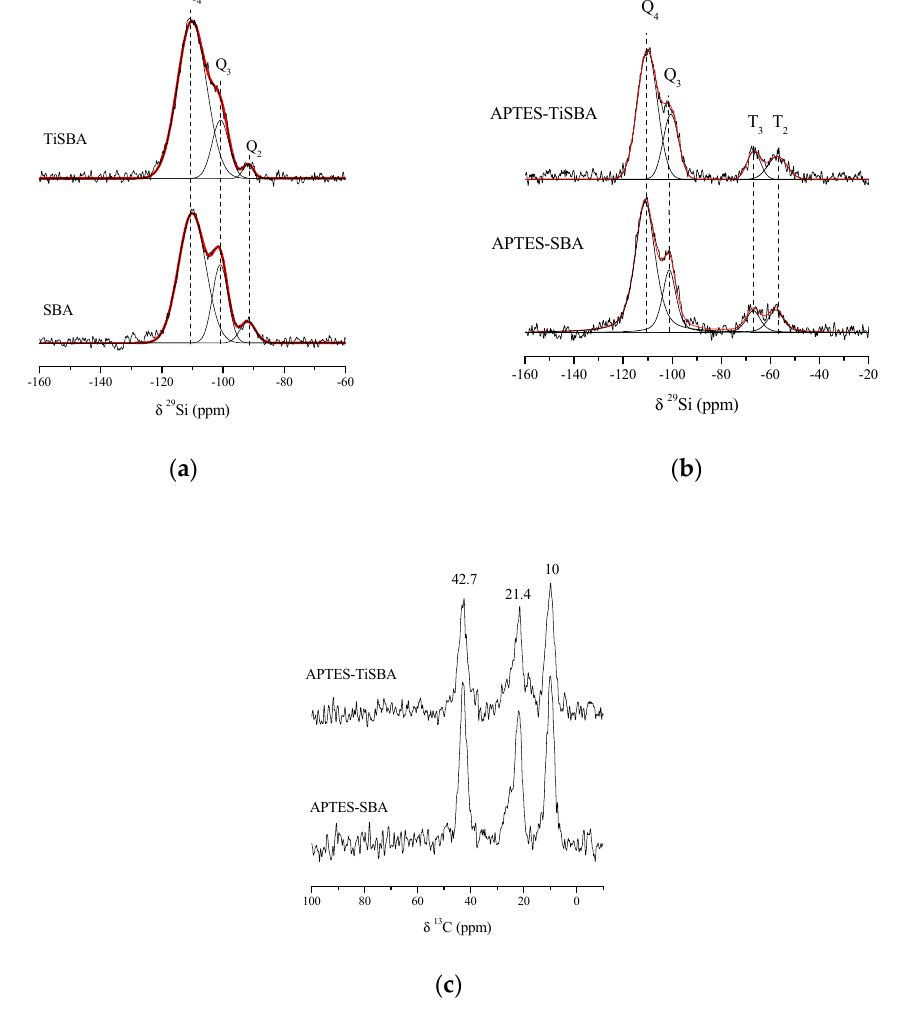
Figure 4. ( a ) 29 Si nuclear magnetic resonance (NMR) spectra of bare supports, ( b ) 29 Si NMR spectra and ( c ) 13 C NMR spectra of APTES functionalized SBA and Ti-SBA.